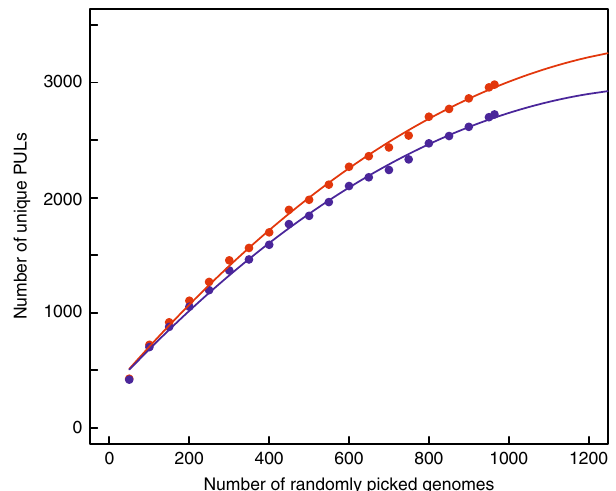
Fig. 4 Number of unique PULs according to the number of genomes analyzed. The number of PULs was calculated by randomly resampling an increasing number of genomes from our data set (x-axis). The resampling was performed ten times; the median value is represented on the y -axis. A second order polynomial regression gives the trend of two sets of values corresponding to 0 (red) and 20% (blue) mismatch used during